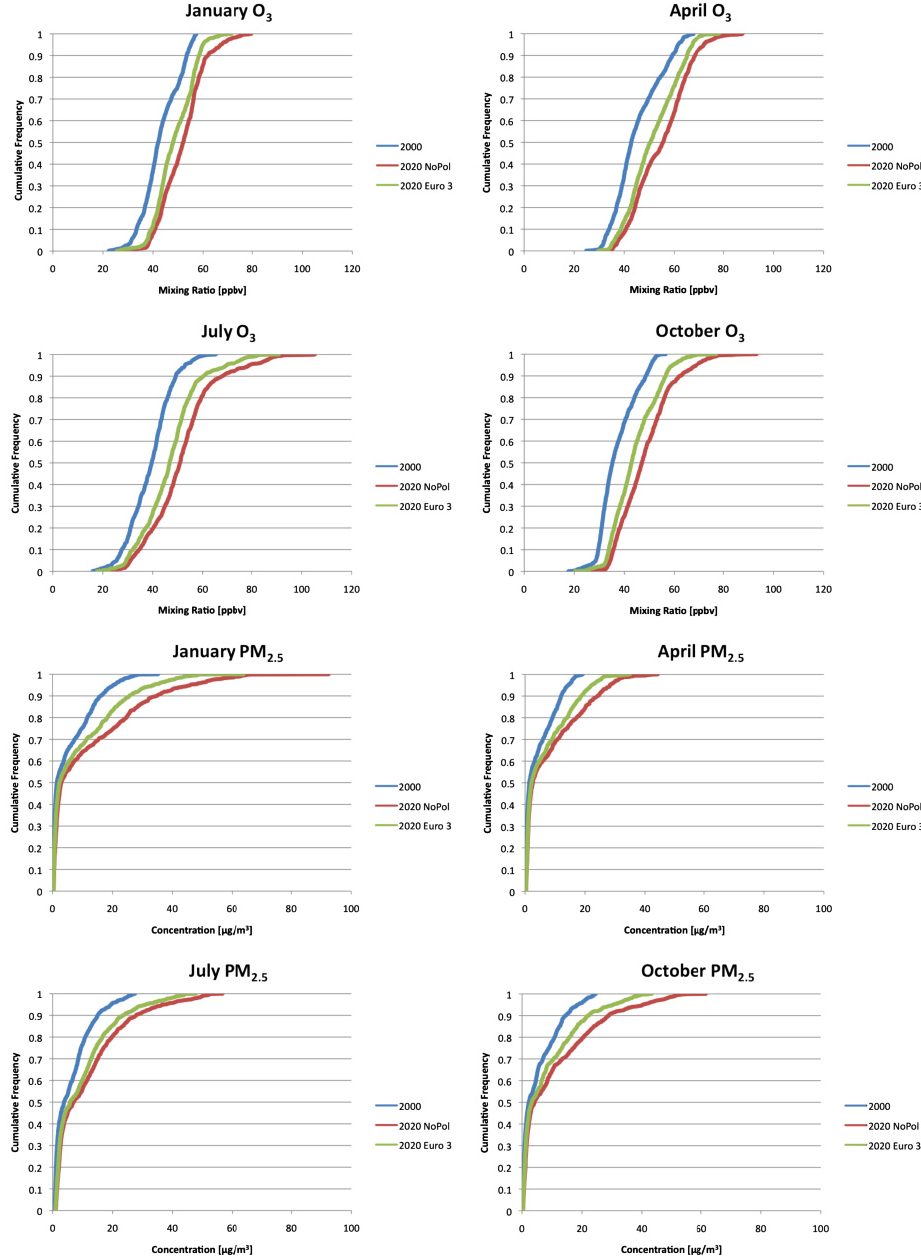
Fig. 10. Cumulative frequency of China’s surface O 3 mixing ratios (ppbv), and PM 2 . 5 concentrations (µgm − 3 ) in January, April, July and October modelled by